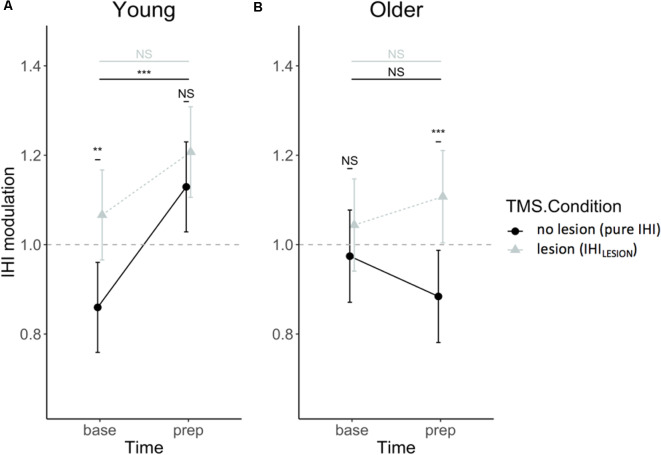
IHI modulation expressed relatively to single-pulse TMS, in IHI (dots) and IHILESION values (triangles), for young (A) and older (B) adults. Values above 1 indicate a facilitatory effect of the CS on DLPFC to contralateral M1. Values lower than 1 indicate an inhibitory effect of the CS on DLPFC to contralateral M1. Error bars indicate 95% CIs. Abbreviations: NS, Not Significant; **p < 0.01; ***p < 0.001.